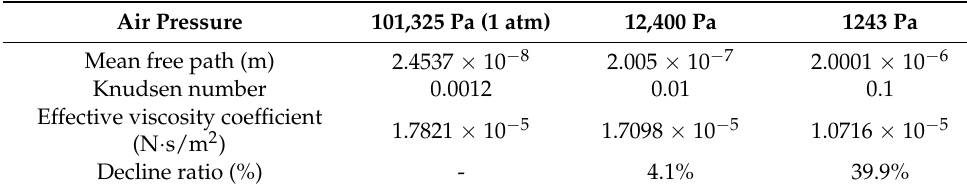
Figure 2. The dependence of the effective viscosity coefficient of air on the air pressure. Table 2. The changes in the relevant parameters of the air when the air pressure drops.